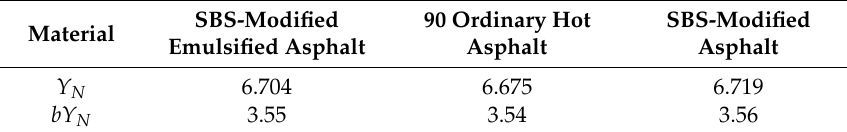
Table 12. bY N values for di ff erent bonding